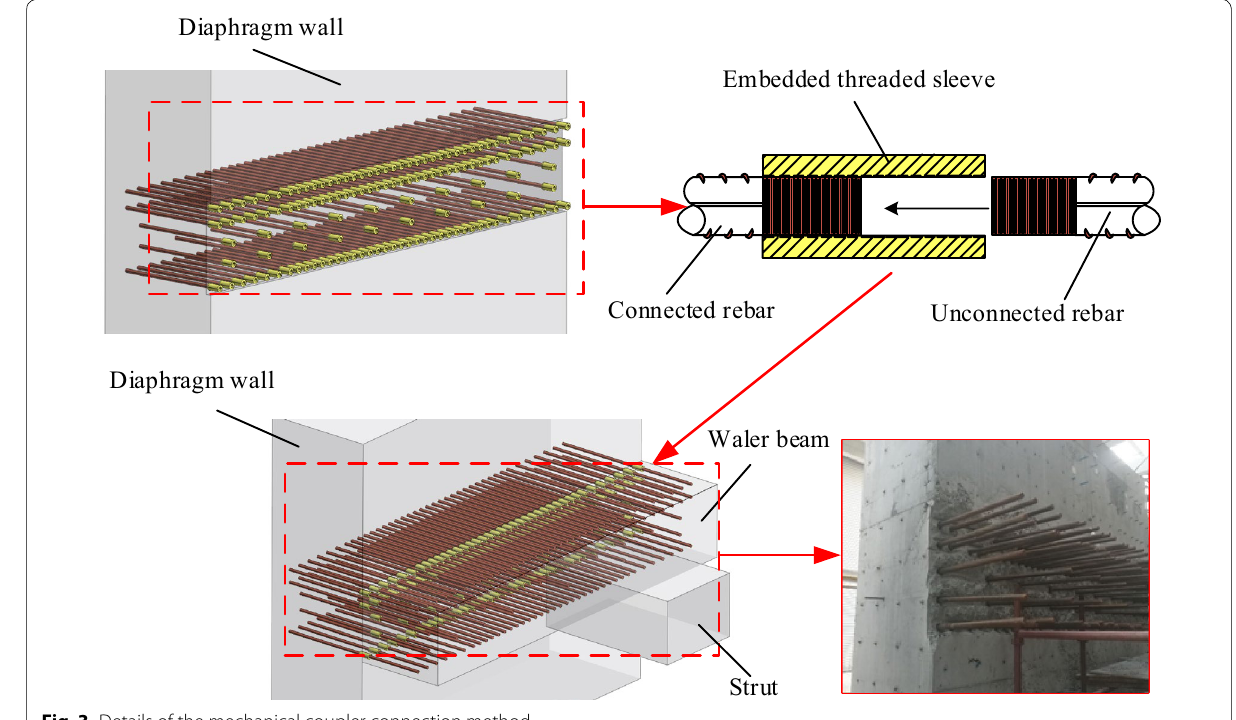
Fig. 3 Details of the mechanical coupler connection method.